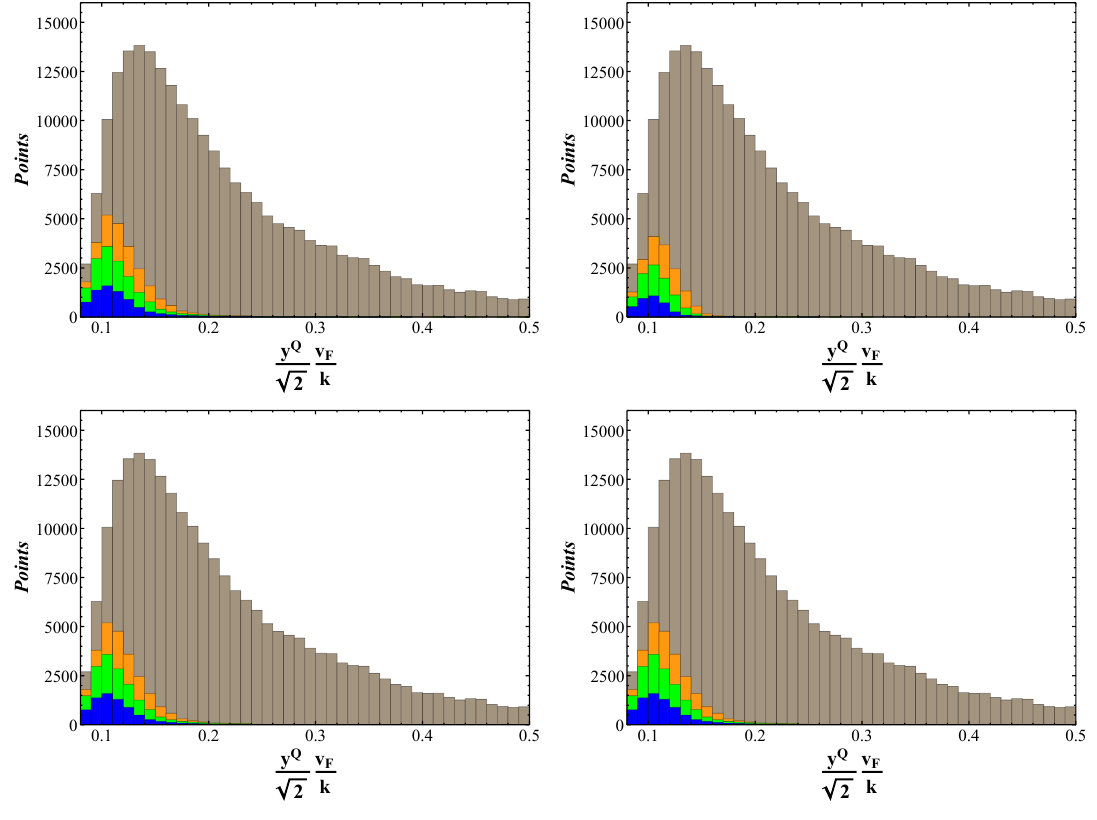
Figure 11. Histograms of the y Q , for g A = g B = 0 : 1 and v F =k = 0 : 1 (top left), g A = g B = 1 : 0 and v F =k = 0 : 1 (top right), g A = g B = 0 : 1 and v F =k = 1 : 0 (bottom left), and g A = g B = 1 : 0 and v F =k = 1 : 0 (bottom right). The blue represents points which satisfy the 68% CL experimental limit in the h (cid:0) (cid:27) d plane, the green represents the 95% CL region, the orange represents the 99.7% CL region, and the beige includes all points in our sample pool, with no h d (cid:0) (cid:27) d